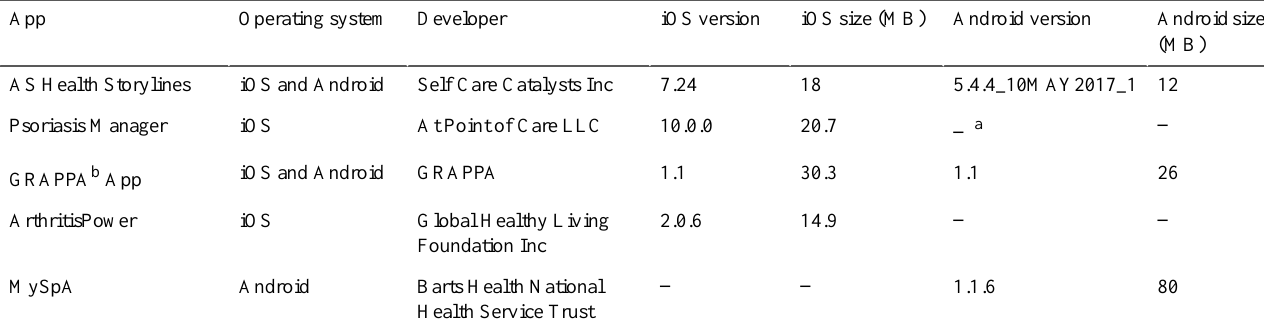
Table 2. Operating system, developer, version, and size of included apps.